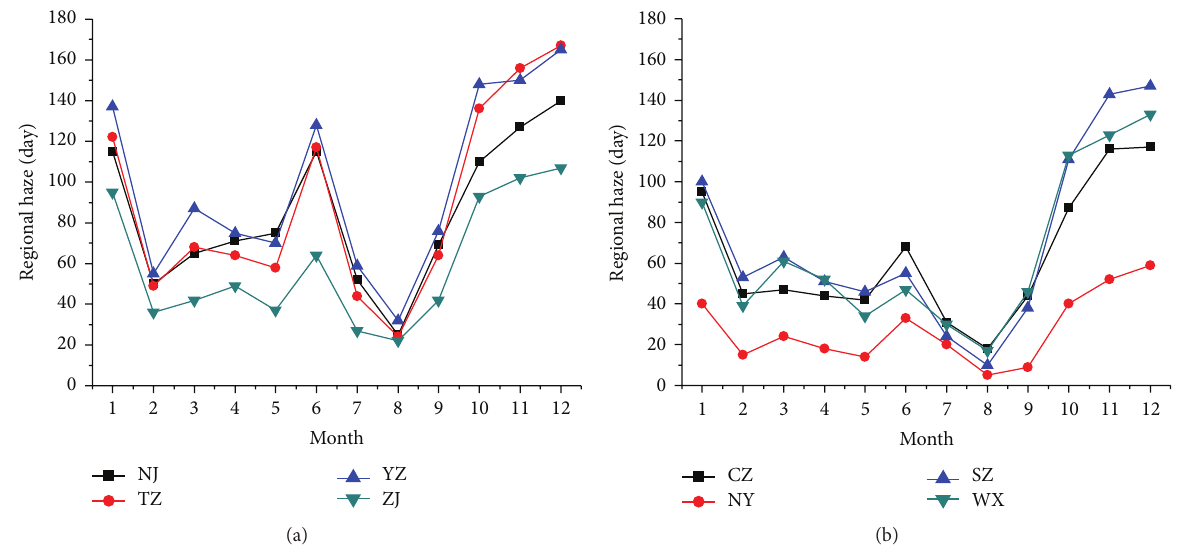
Figure 7: Monthly changes of regional hazy day south of the Huaihe River (summer of 33 years).